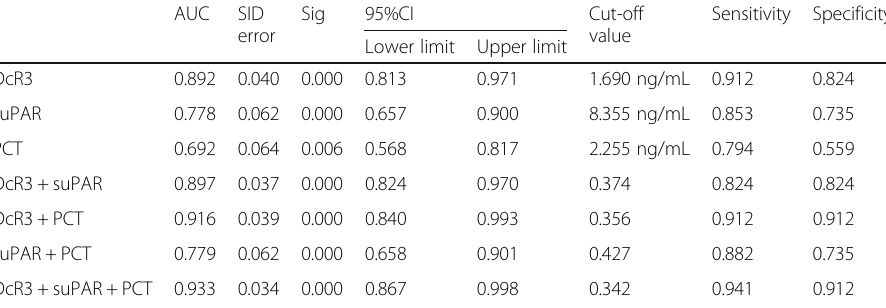
Table 4 Receiver operating characteristic analysis of DcR3, suPAR and PCT in SIRS and